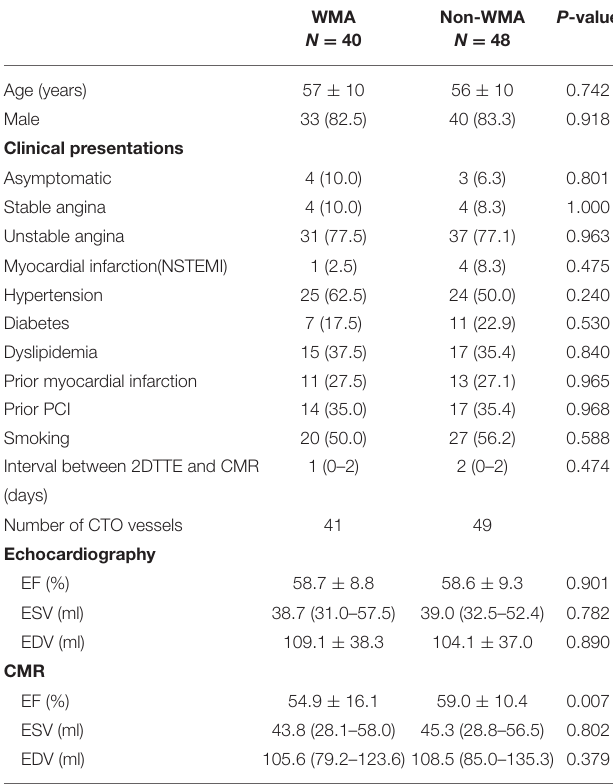
TABLE 5 | Comparison of patients with and without regional wall motion abnormality detected by 2DTTE. CMR EF ≥ 50% < 50%